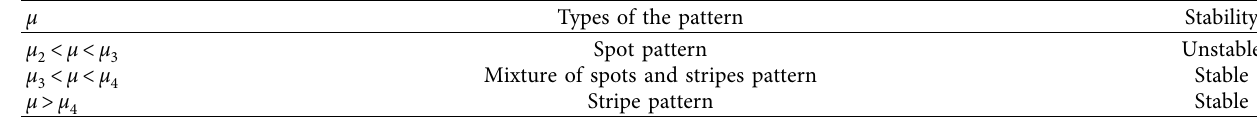
Table 1: Te domain of pattern selection.